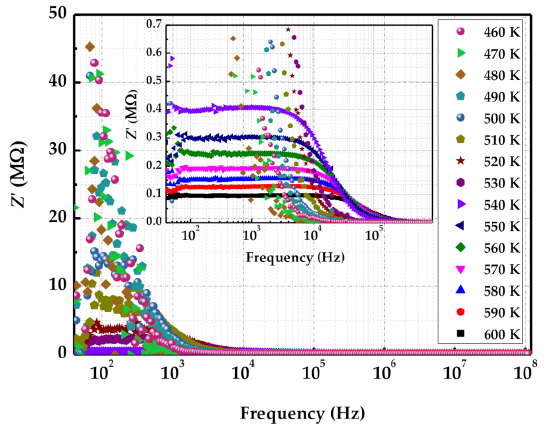
Figure 4. Evolution of the real part of the impedance ( Z ’) as function of the frequency at various temperatures of the In 2 S 3 :Ag thin film. The inserted graph (higher resolution of the same graph) highlights the impedance variation in the high temperature